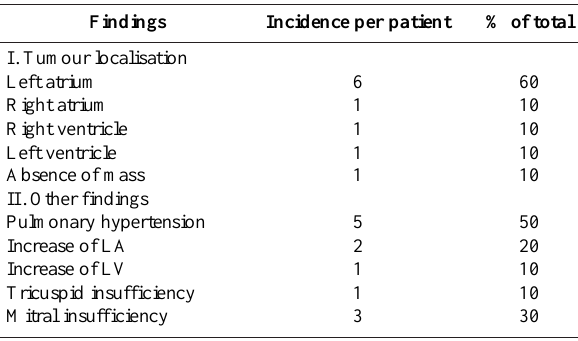
Table 6. Cardiac catheterism in patients with cardiac